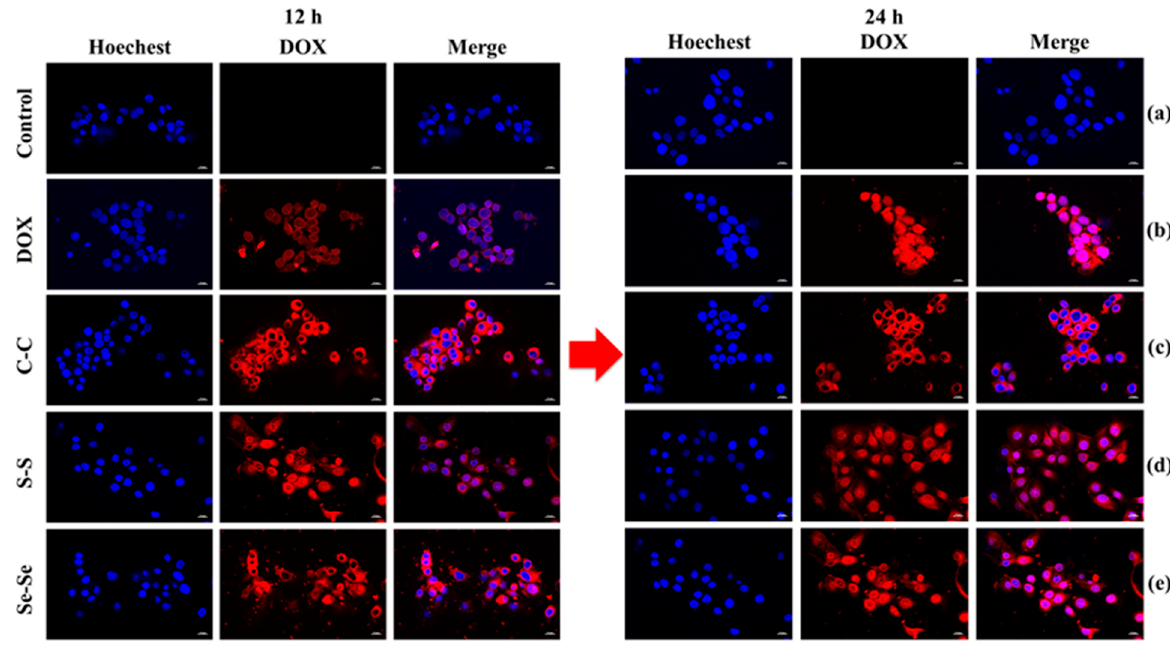
Figure 10. The CLSM images from left to right (each panel) display DOX fl uorescence (red), BT-20 cell nuclei stained with DAPI (blue), and overlays of both images (merged). Non-treated cells ( a ), free DOX ( b ), and BT-20 cells treated with C–C/S–S/Se–Se CCL/DOX micelles ( c – e ) for 12 h and 24 h; the scale bar is 20